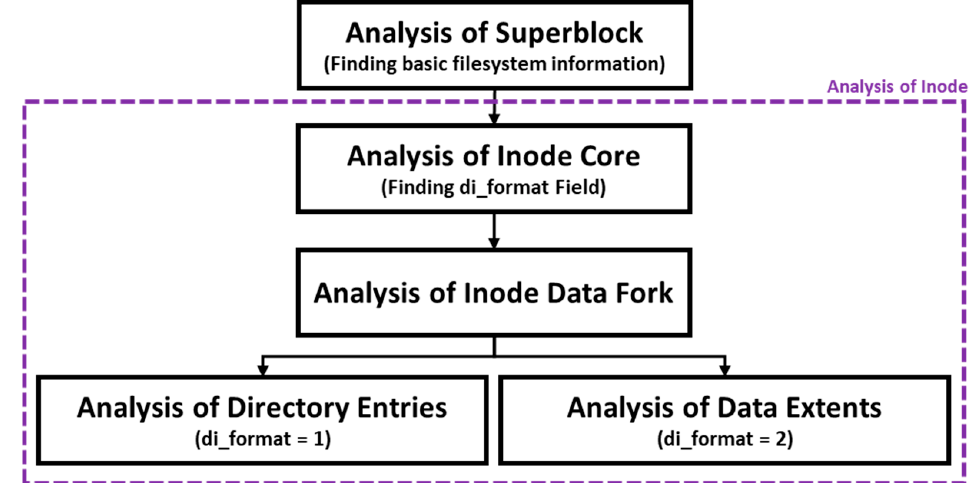
Figure 10. XFS v5-based file extraction module using TSK.